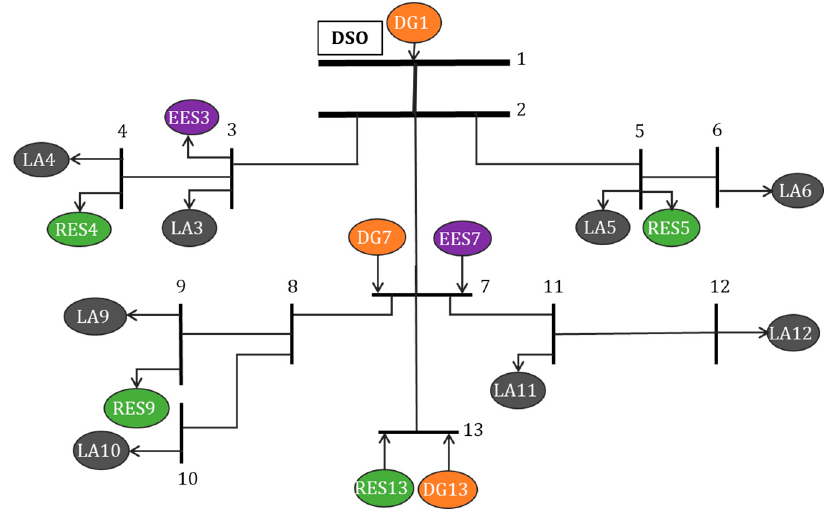
Figure 2. Radial IEEE 13-bus distribution system with different types of distributed energy resources (DERs) on each bus.